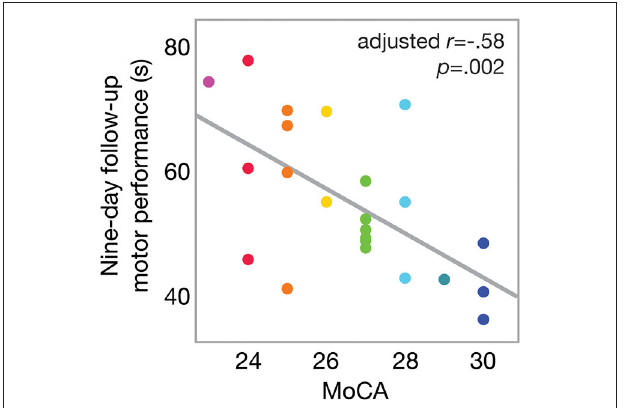
FIGURE 3 | Scatterplot of motor performance at 9-day follow-up as a function of MoCA score. Bivariate linear correlation results are shown in figure. Color gradient corresponds to that in Figure 2